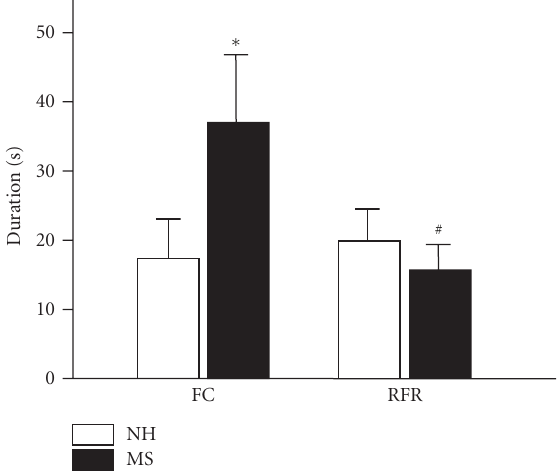
Figure 3: Immobility durations of rats during forced swim test. Rats were subjected to forced swim test at the end of the 18th refeeding session. ∗ P < 0.05 versus NH/FC, # P < 0.05 versus MS/FC, NH: nonhandled, MS: maternal separation, FC: free fed control, RFR: repeated fasting/refeeding, sec: seconds. Data are presented as means ±